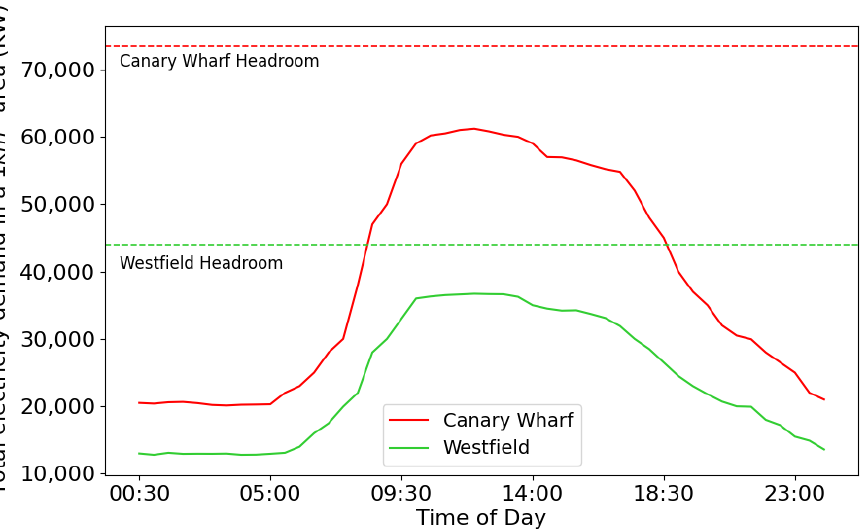
Figure 4. Typical winter weekday baseload curves for the areas of analysis (dashed lines represent installed capacity for the scenario of 20% overload capacity).